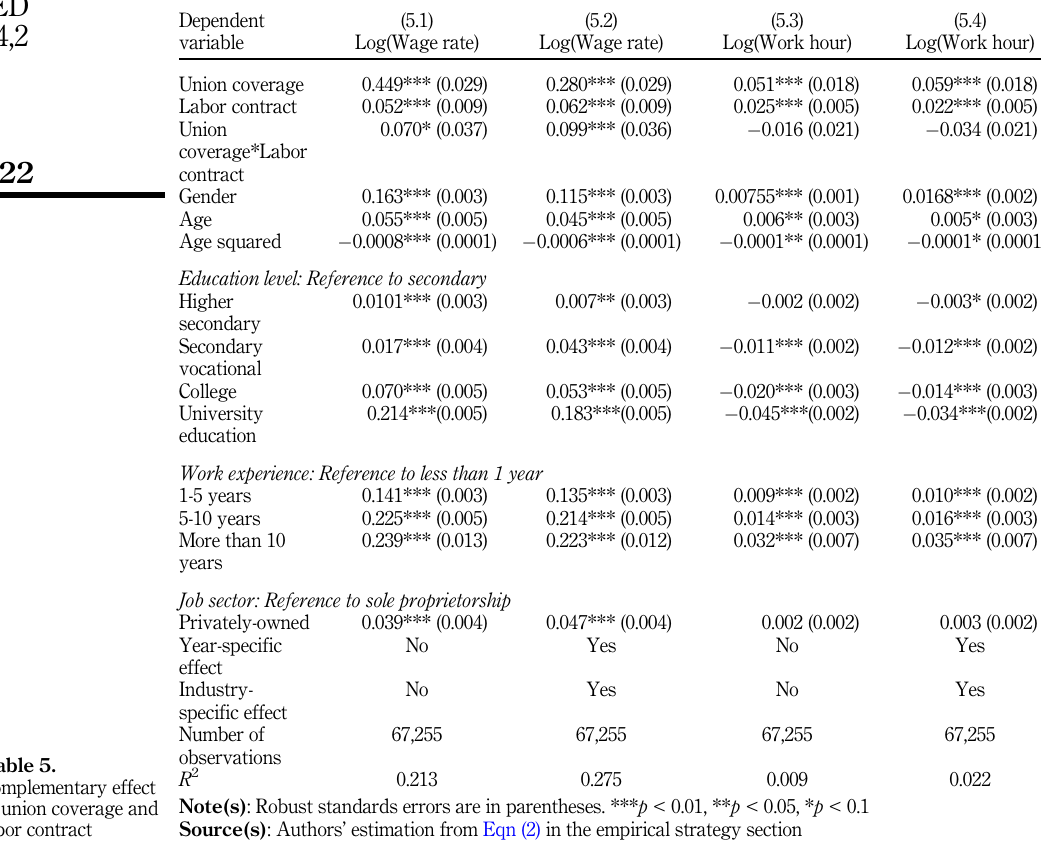
Table 5. Complementary effect of union coverage and labor